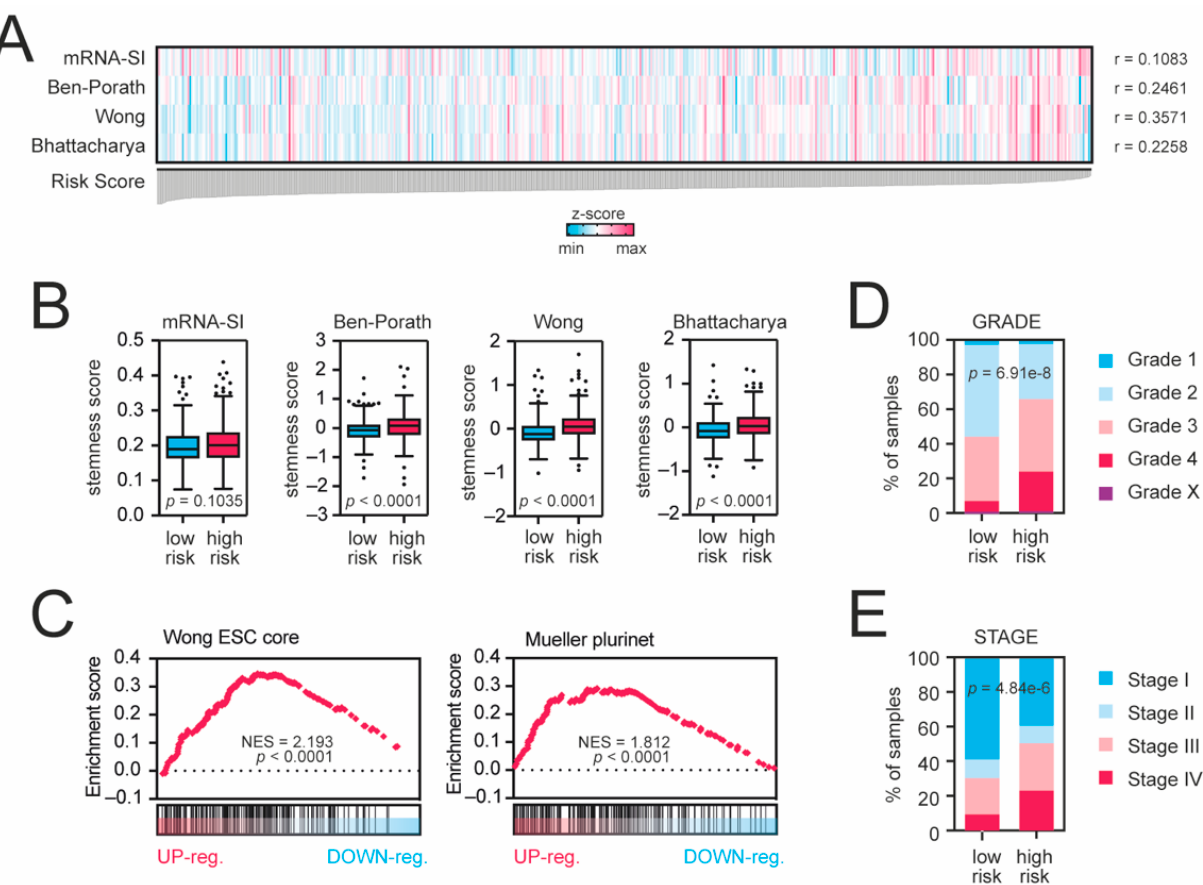
Figure 4. Tumors from high-risk patients exhibit cancer stem cell-like traits. ( A ) KRAB-ZNF-based risk score is significantly correlated with cancer stemness scores. All samples were ranked according to the risk score value. Blue and magenta present lower and higher stemness scores, respectively (z-score-transformed). ( B ) Tukey box plots presenting the levels of stemness scores in low-risk (blue) and high-risk (magenta) KIRC patients. ( C ) The transcriptome profiles of high-risk KIRC patients are significantly enriched with stemness markers. The GSEA using all significantly differentially expressed genes (DEGs with p < 0.05 and FDR < 0.05) in high-risk KIRC patients was performed with the stemness signatures “Wong_ESC_core” or “Mueller_Plurinet” as references. ( D ) Tumors from high-risk patients are higher-grade tumors. Tumor grades are color-coded as presented in the legend. ( E ) Among the high-risk patients, the frequency of higher stage is more significantly elevated. Tumor stages are color-coded as presented in the legend.